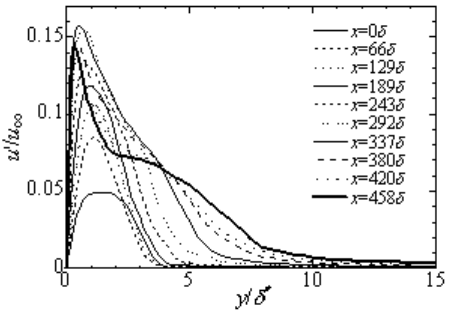
Fig. 3 Velocity fluctuations in a Mach 3 boundary